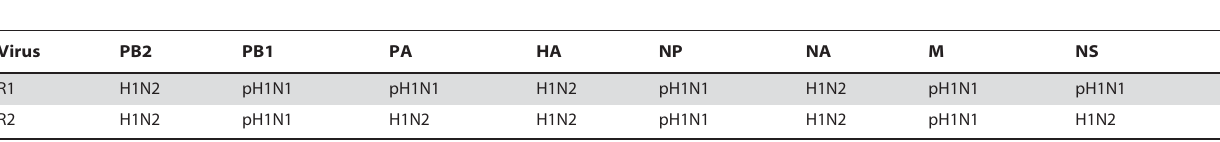
Table 1. The lineage of the eight segments of the reassortant viruses genomes were determined by complete genome sequencing of reassortant viruses R1 and R2.